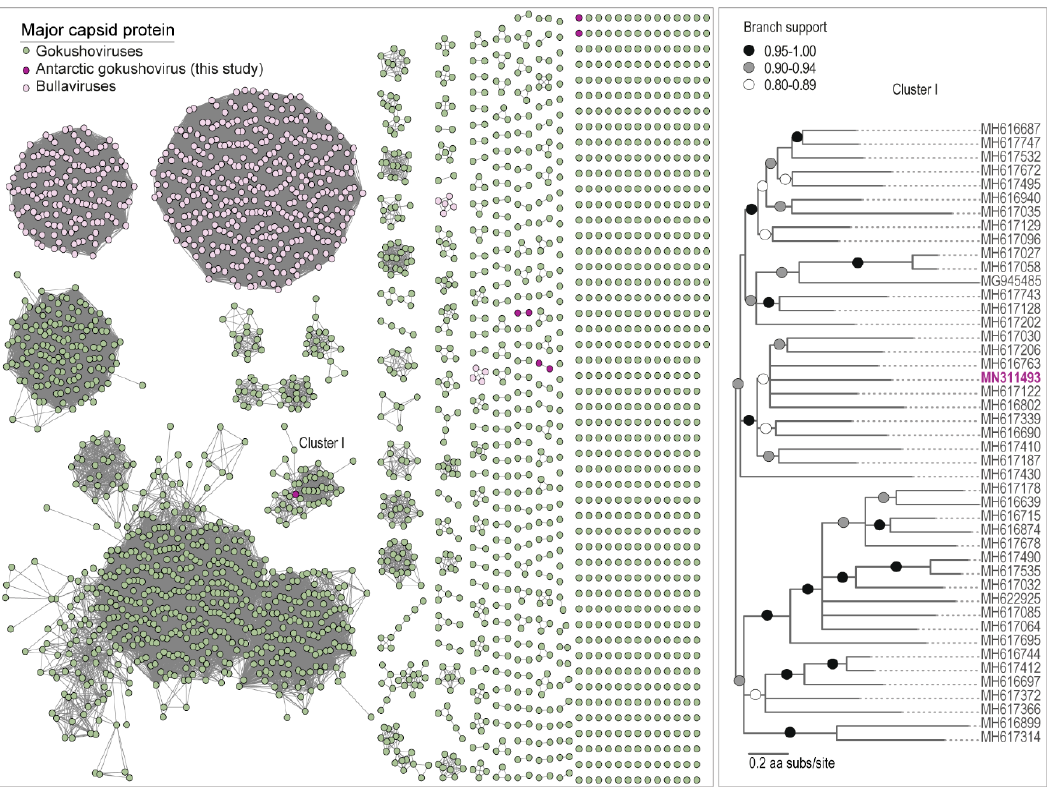
Figure 4. The sequence similarity network analysis of the major capsid protein (MCP) amino acid sequences of microviruses identified from cryoconite together with those available in GenBank is shown in the left panel. The Maximum Likelihood phylogenetic tree of MCP amino acid sequences for the cluster of MCPs of viruses from the large cluster (Cluster I) is shown in the right panel. Branches with <0.8 aLRT support have been collapsed.